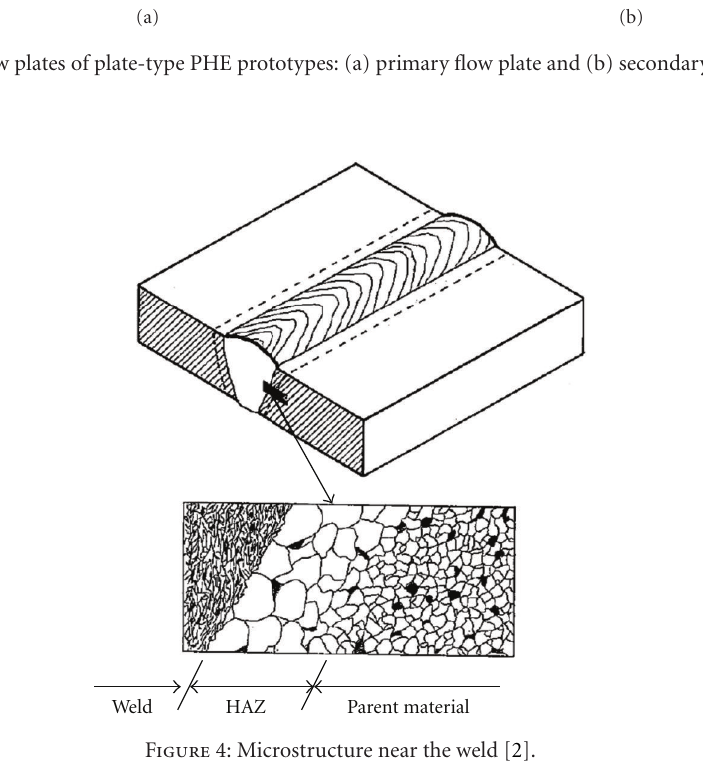
Figure 4: Microstructure near the weld [2].